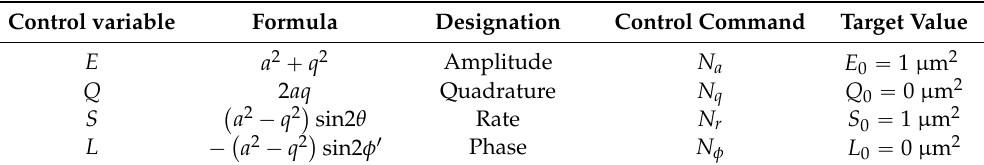
Table 5. The design of control variables.